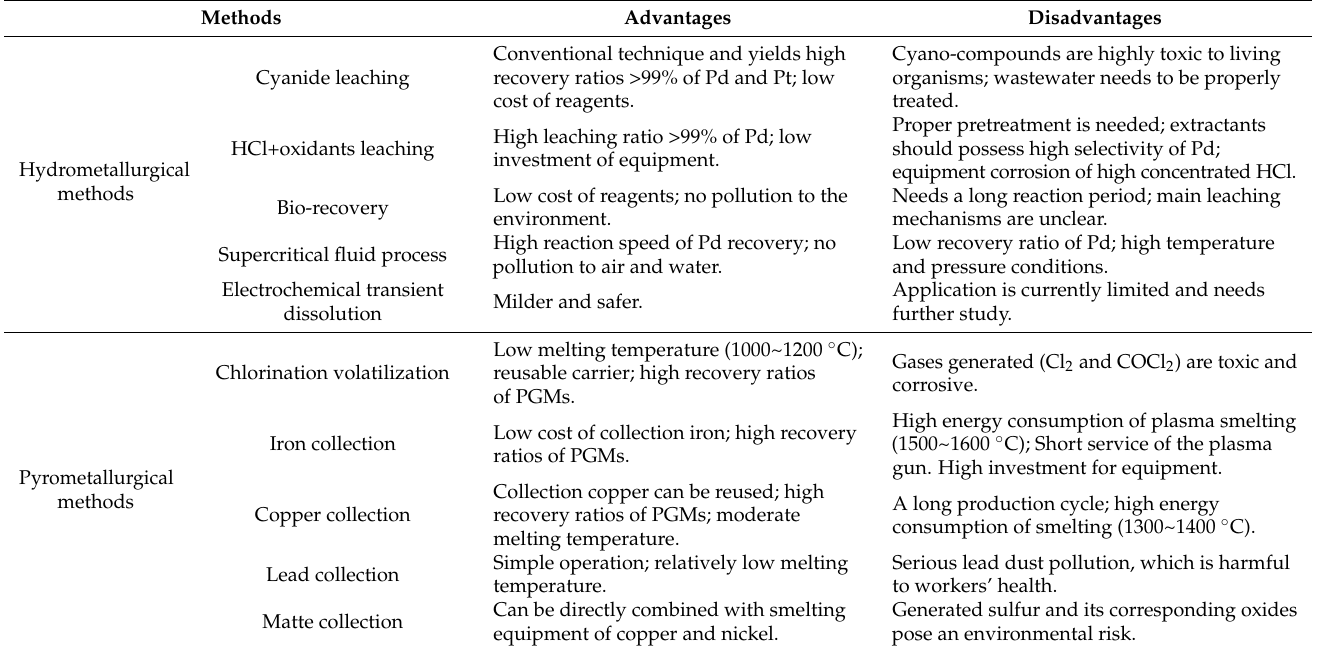
Table 7. Comparison of pyro/hydrometallurgical methods for the recovery of palladium from the spent automobile